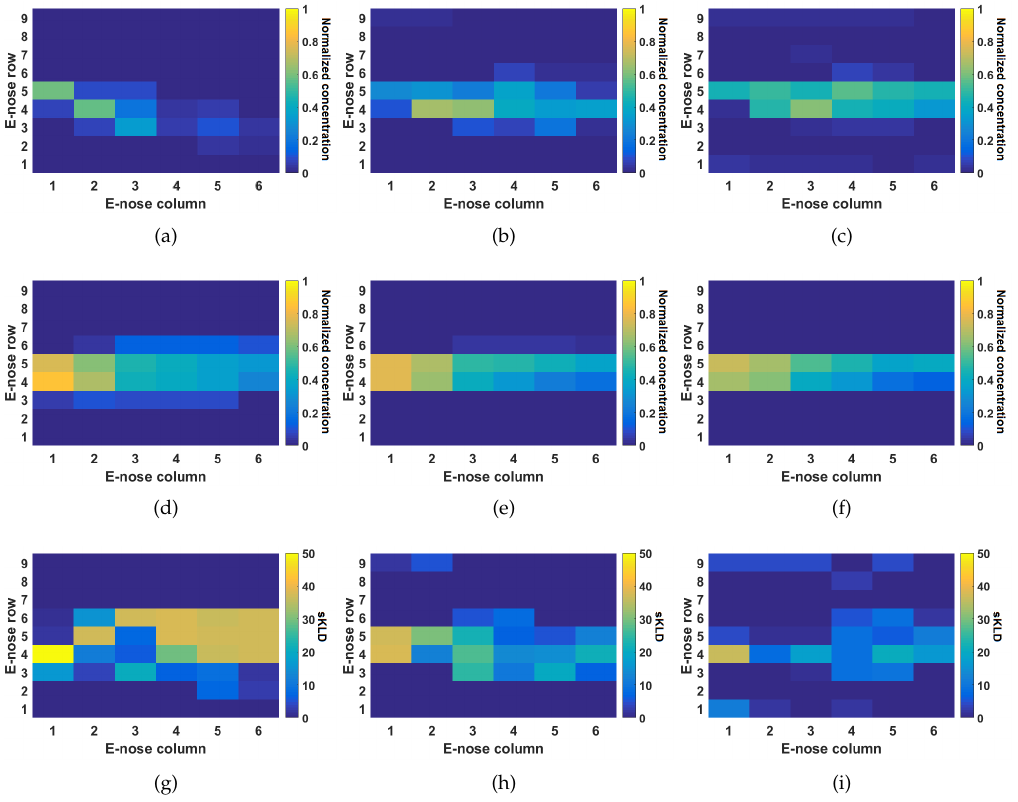
Figure 8. Comparison results between actual data collected in a wind tunnel and simulations. The experiments and simulations were conducted under different airflow profiles. ( a , d , g ) correspond to 0.1 m/s. ( b , e , h ) to 0.21 m/s. ( c , f , i ) correspond to 0.34 m/s. ( a – c ) correspond to actual